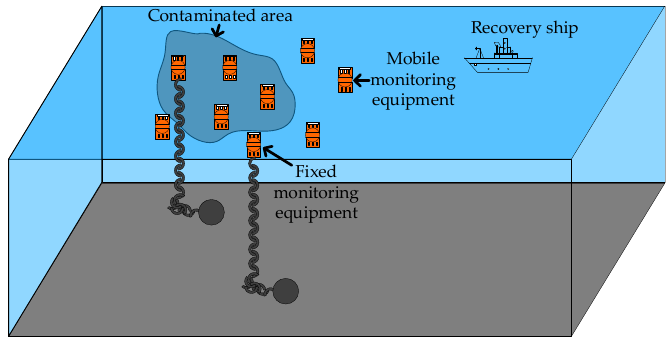
Figure 1. Schematic diagram of marine environmental buoy monitoring.